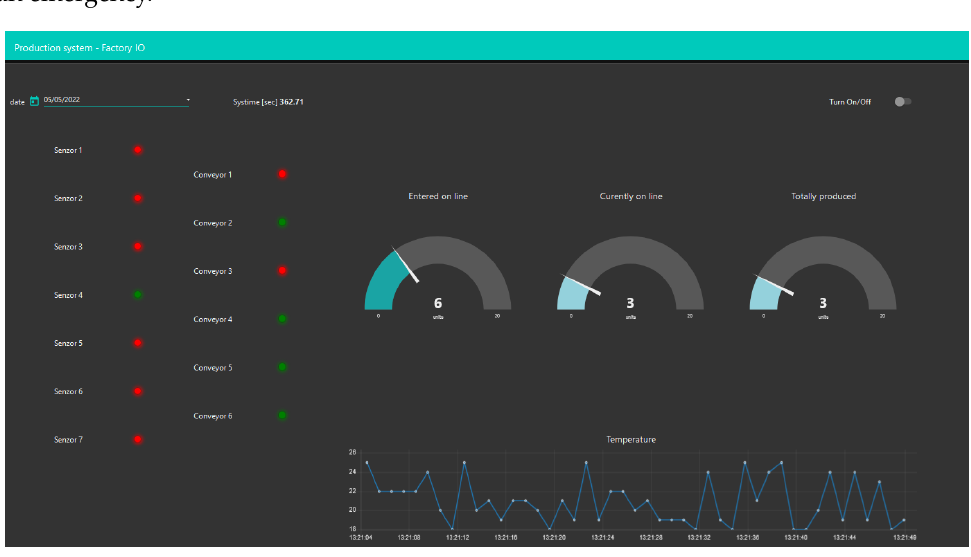
Figure 23. Dashboard in Node-RED (cloud).